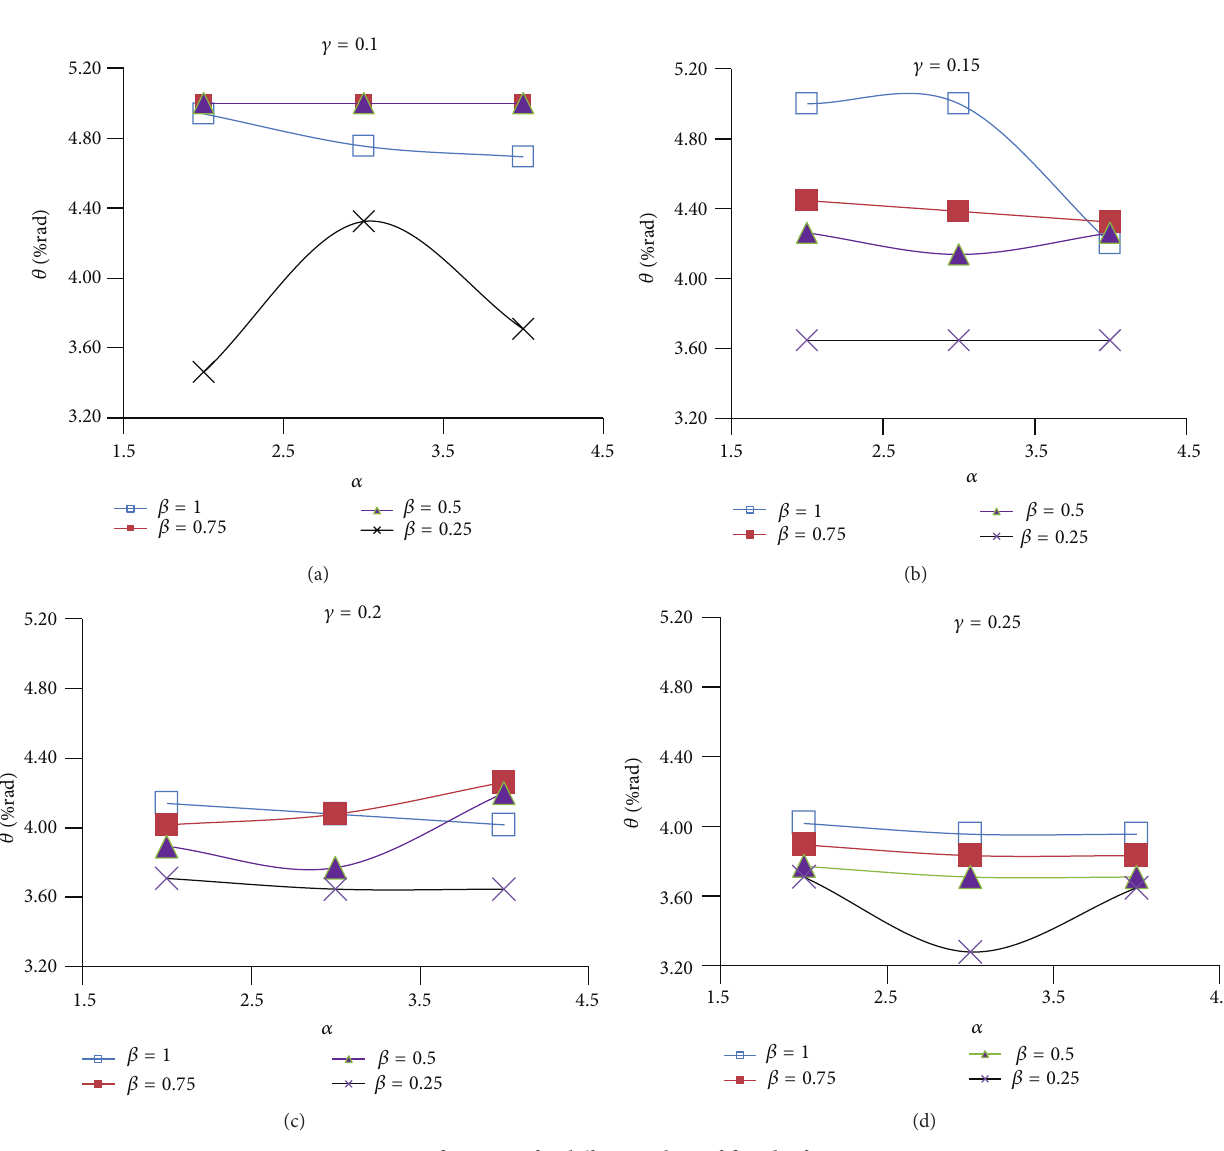
Figure 9: 𝜃 versus 𝛼 for different values of 𝛽 and 𝛾 for